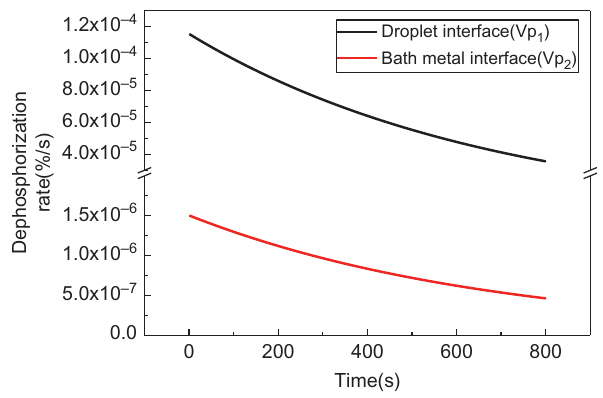
Figure 3: Comparison of dephosphorization rates at different